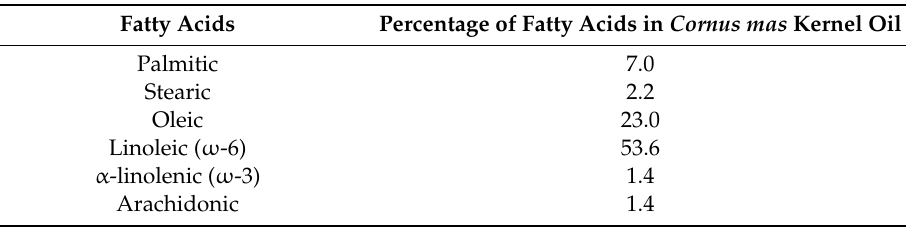
Table 5. Composition of Cornus mas kernel oil in fatty acids (%).